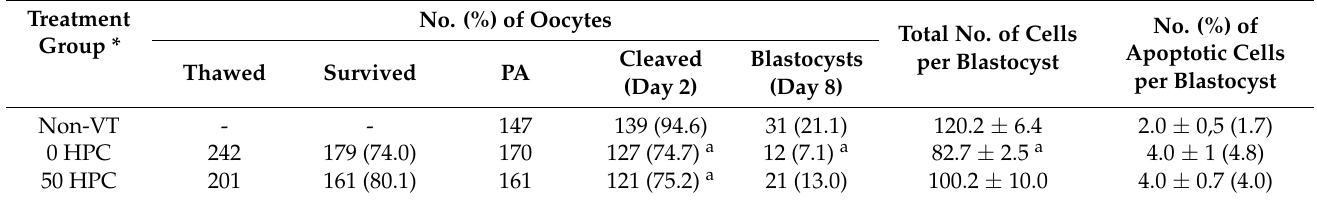
Table 3. Comparison of in vitro development between non-VT and VT groups following PA when HPC was supplemented during freezing ( n = 5).